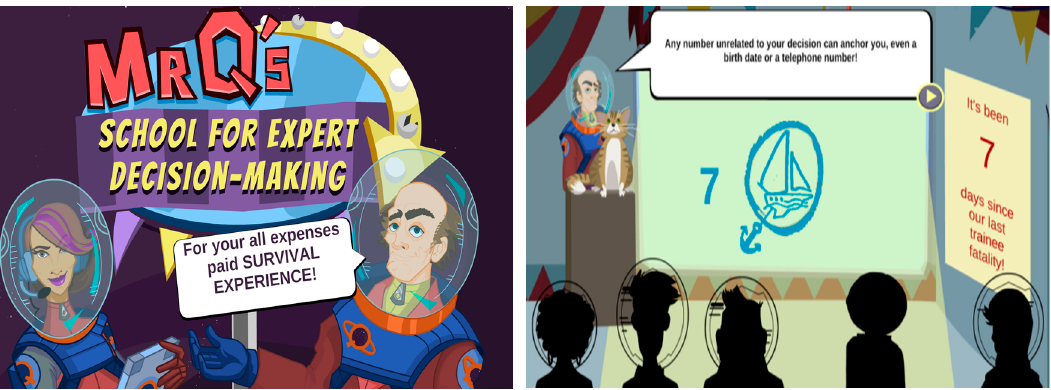
Figure 3. Screenshots of the final and best version of CYCLES Carnivale game illustrate the title screen and an example of one of the challenge rooms the player needed to navigate.